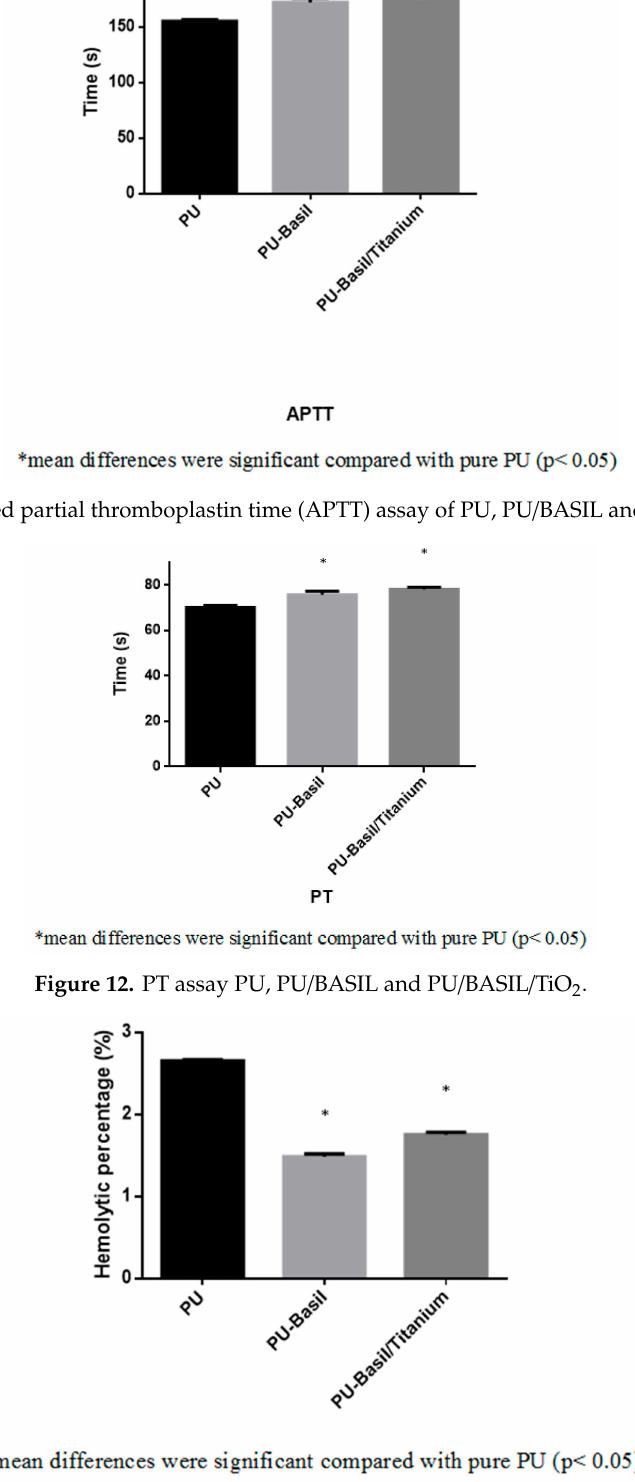
Figure 13. Hemolytic assay PU, PU / BASIL and PU / BASIL / TiO 2